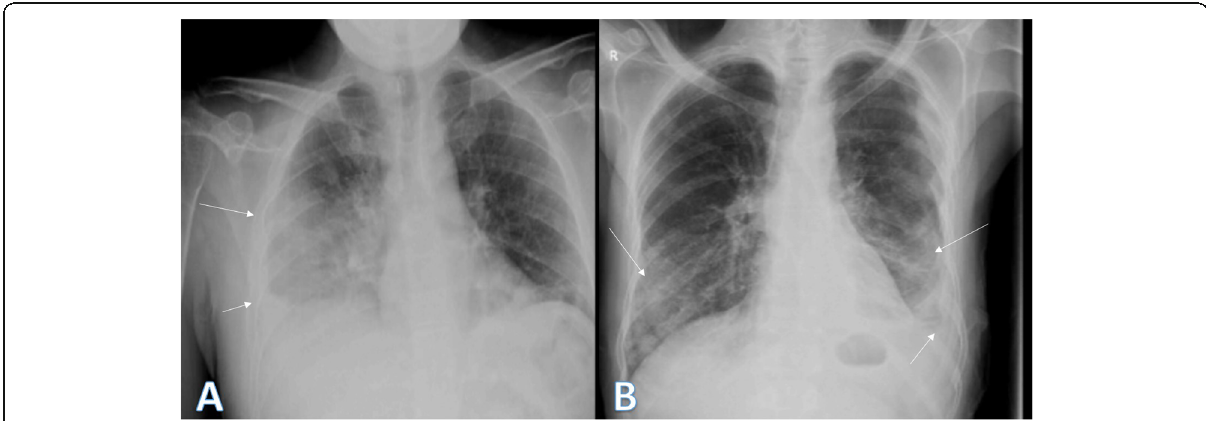
Fig. 10 Two different patients with positive COVID-19. a 34-year male was complaining of cough and fever. Follow-up chest X-ray showed mild right pleural effusion (short arrow) with right mid and lower zonal air space consolidation opacities (long arrow). The total severity score was 2. b 61-year male was complaining of fever, cough, and diarrhea. Follow-up chest X-ray showed mild left pleural effusion with bilateral lower zonal air space consolidation opacities (long arrows). The severity score was 2 for each lung, so TSS was